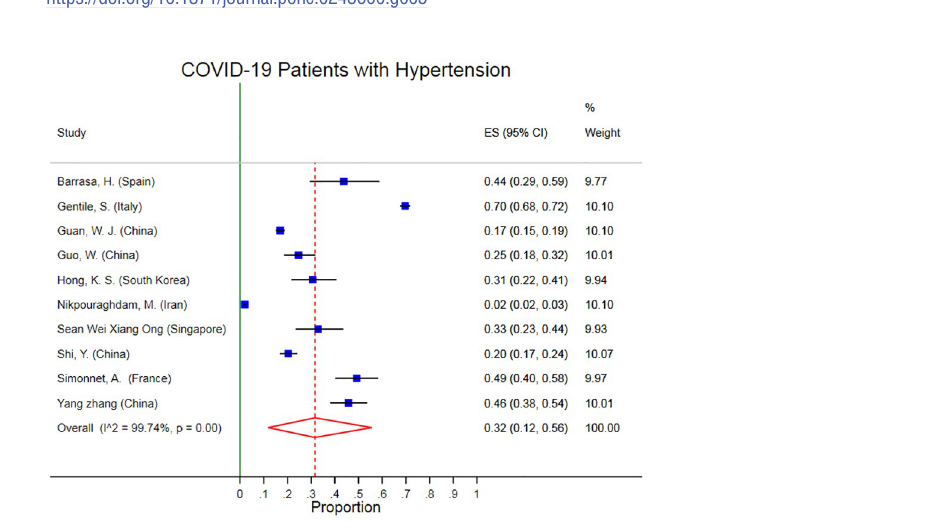
Fig 6. Forest plots of pooled prevalence of hypertension in Covid-19 patients.